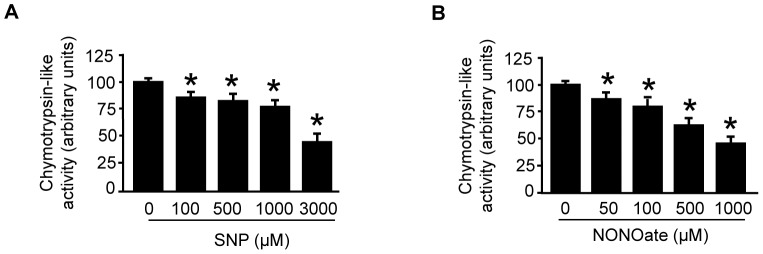
NO at high concentrations inhibits the activity of purified 26S proteasomes.(A) SNP decreased the chymotrypsin-like activity of the purified 26S proteasome. (B) DETA-NONOate reduced the chymotrypsin-like activity of the purified 26S proteasome. The purified 26S proteasome (Enzo Life Sciences, Inc) were incubated with SNP or DETA-NONOate at indicated concentrations up to 1000 µM for 0.5 h followed by assay of the chymotrypsin-like activity. * represent p<0.05 vs control (n = 3). DETA-NONOate, Diethylenetriamine NONOate; SNP, sodium nitroprusside.